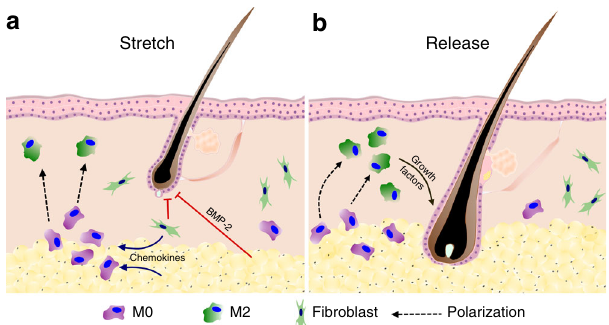
Fig. 7 Schematic of the molecular basis of stretch-induced hair regeneration. a Mechanical stretch promotes BMP-2 production by activating fi broblasts and adipocytes, which inhibit hair regeneration; however, mechanical stretch also stimulates chemokine production to recruit macrophages into the stretched skin. The recruited macrophages undergo M2 polarization in response to a stretched